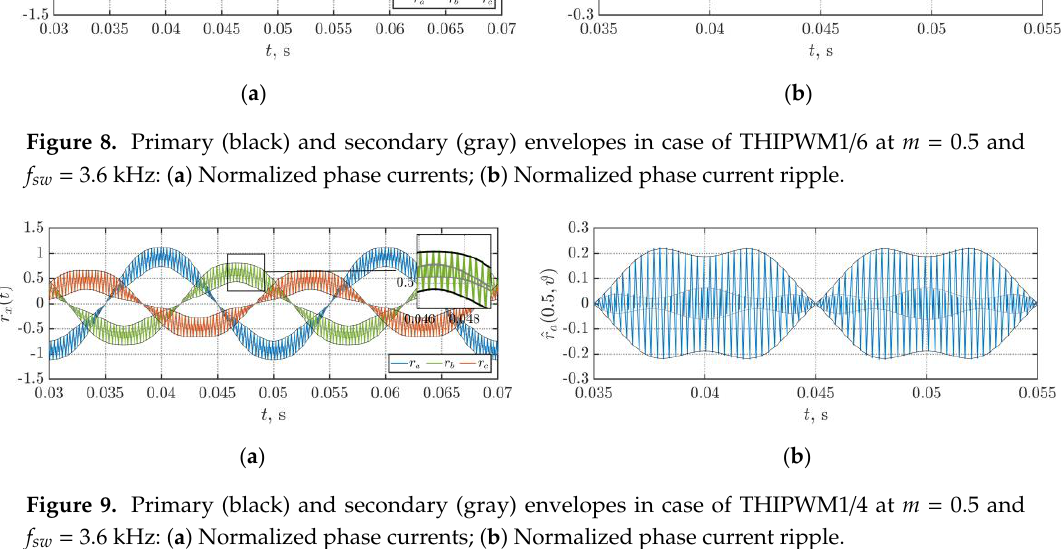
3.6 kHz: ( a ) Normalized phase currents; ( b ) Normalized phase current ripple.